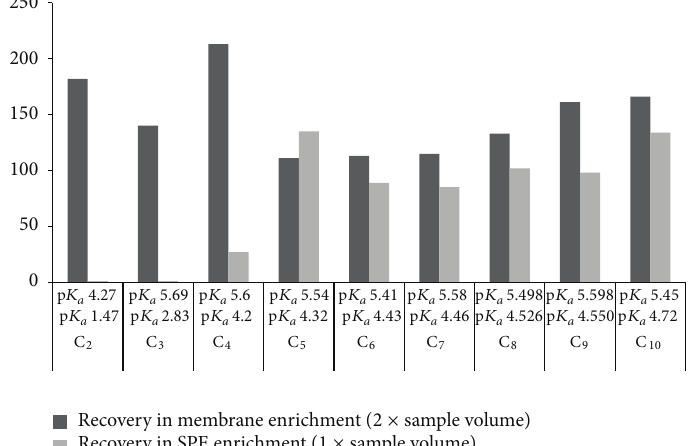
Figure 3: Comparison of enrichment in ME after circulating the samples twice with those made with SPE (Oasis HLB). Sample 25 × 25 cm 2 . The order of the analytes C 1 –C 10 is from left to right. The DCA concentration is 5mg/L. The results are averages of six replicates. The calculations are based on electropherograms of the standard mixture that were analysed after sample collection from the acceptor solution. 100% is normal recycling (see Experimental) and 2x recycling is twice the same sample volume (limited with timing). Analysis conditions as described in